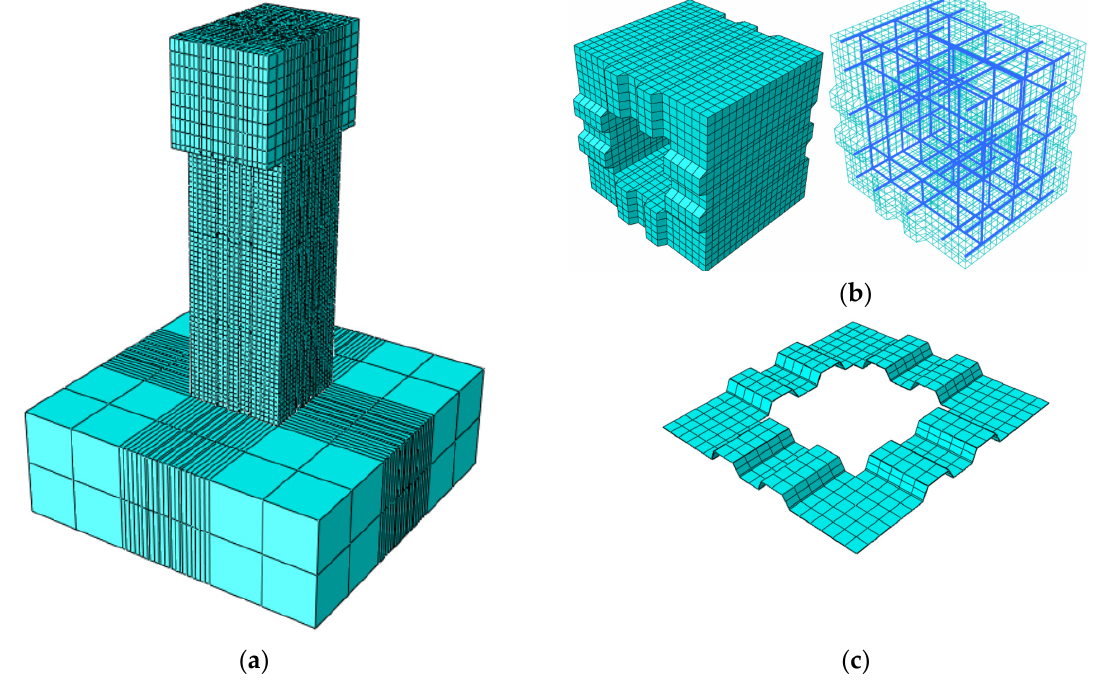
Figure 11. Modeling details of Specimen B2-2. ( a ) Segmental prefabricated bridge piers. ( b ) Segment. ( c ) Glue joint.